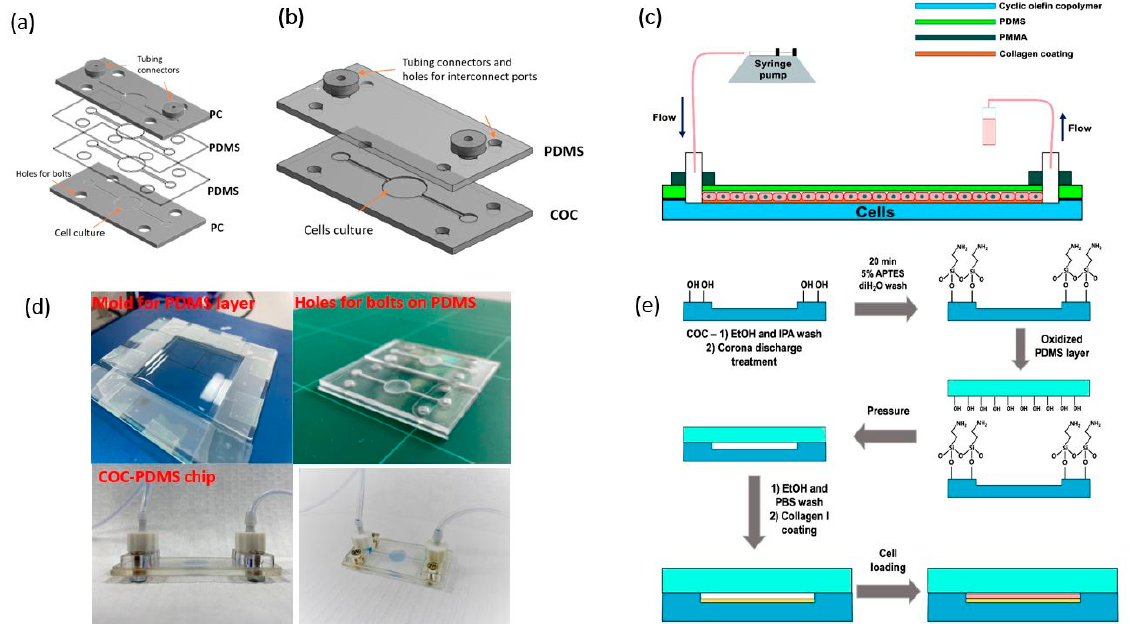
Figure 1. ( a , b ) Assembly view of a polycarbonate–polymethylsiloxane (PDMS) and a hybrid cyclic olefin copolymer (COC)–PDMS (HCP) microfluidic chips for culturing Huh7 hepatoma cell line; ( c ) Continuous flow experimental setup; ( d ) Fabrication of a PDMS layer and an image of the assembled HCP chip; ( e ) Schematic illustration of a COC–PDMS bonding and preparation of the microfluidic device seeded with cell culture.